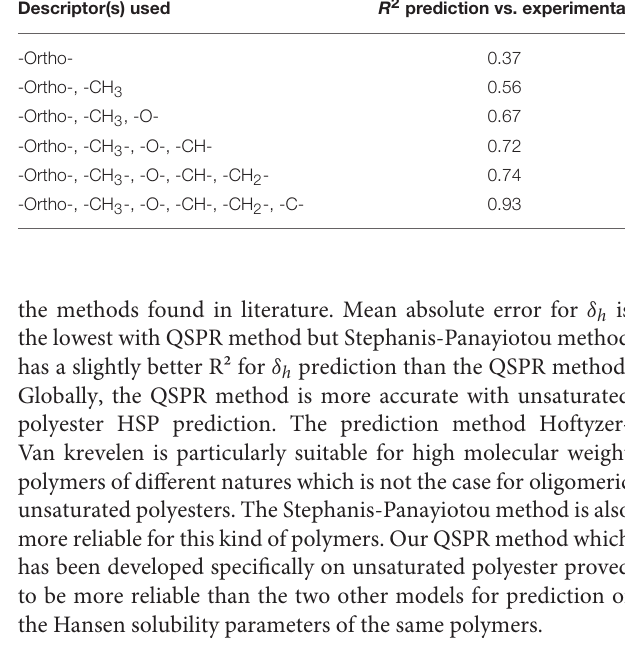
TABLE 5 | Evolution of the correlation coefficient ( R ² ) depending of the descriptors used for T g modeling. Descriptor(s)